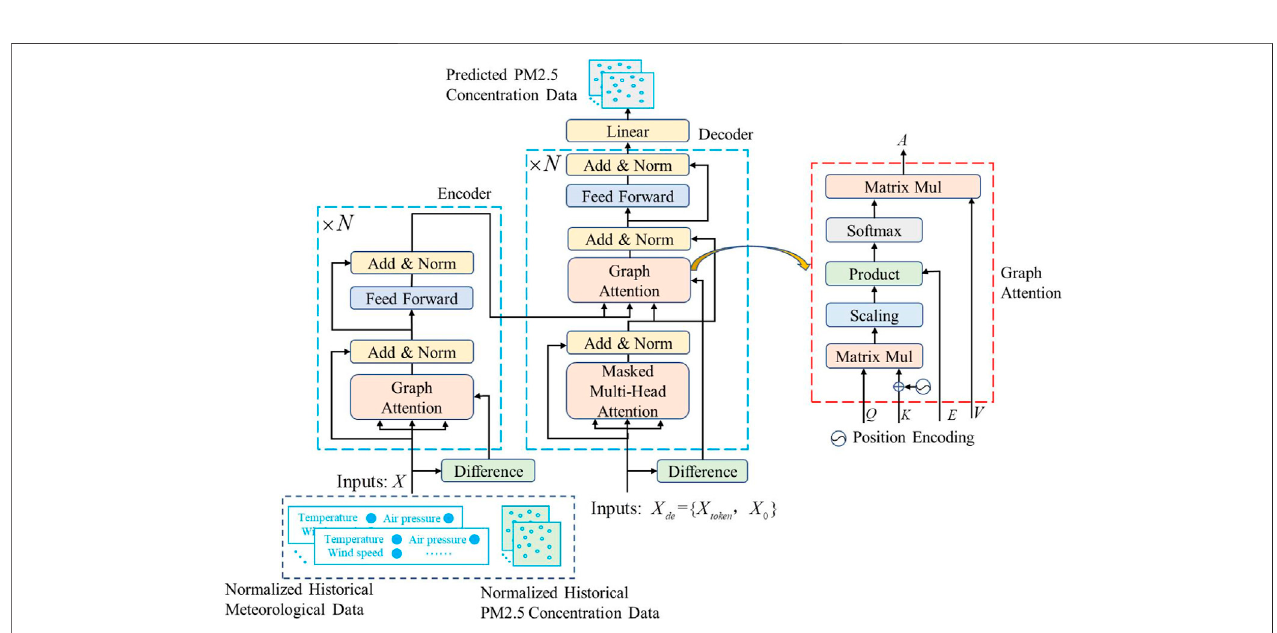
Frontiers in Environmental Science |